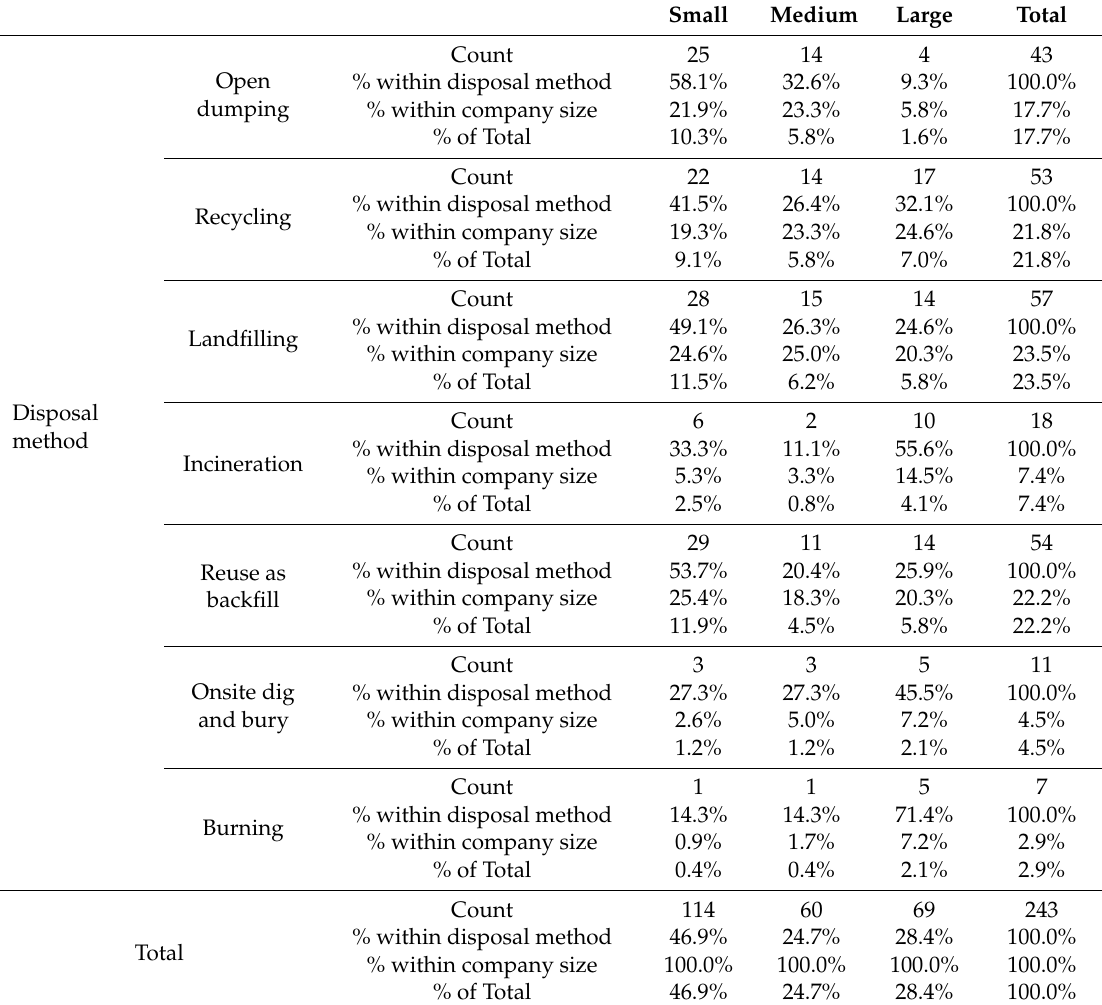
Table 7. Cross tabulation of disposal methods and company